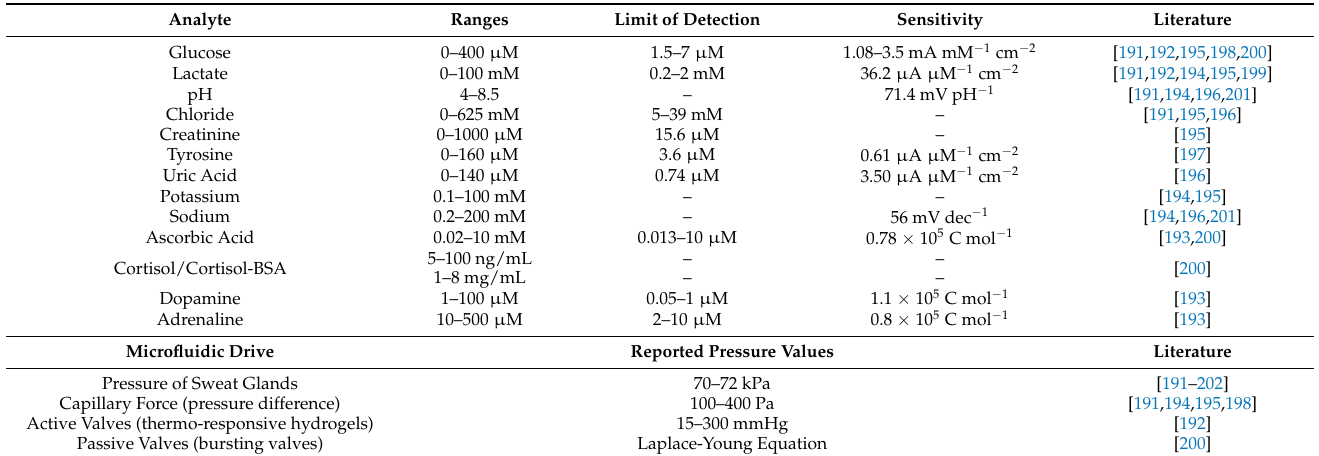
Table 2. Biomarkers and driving mechanisms in wearable microfluidic Bio-MEMS